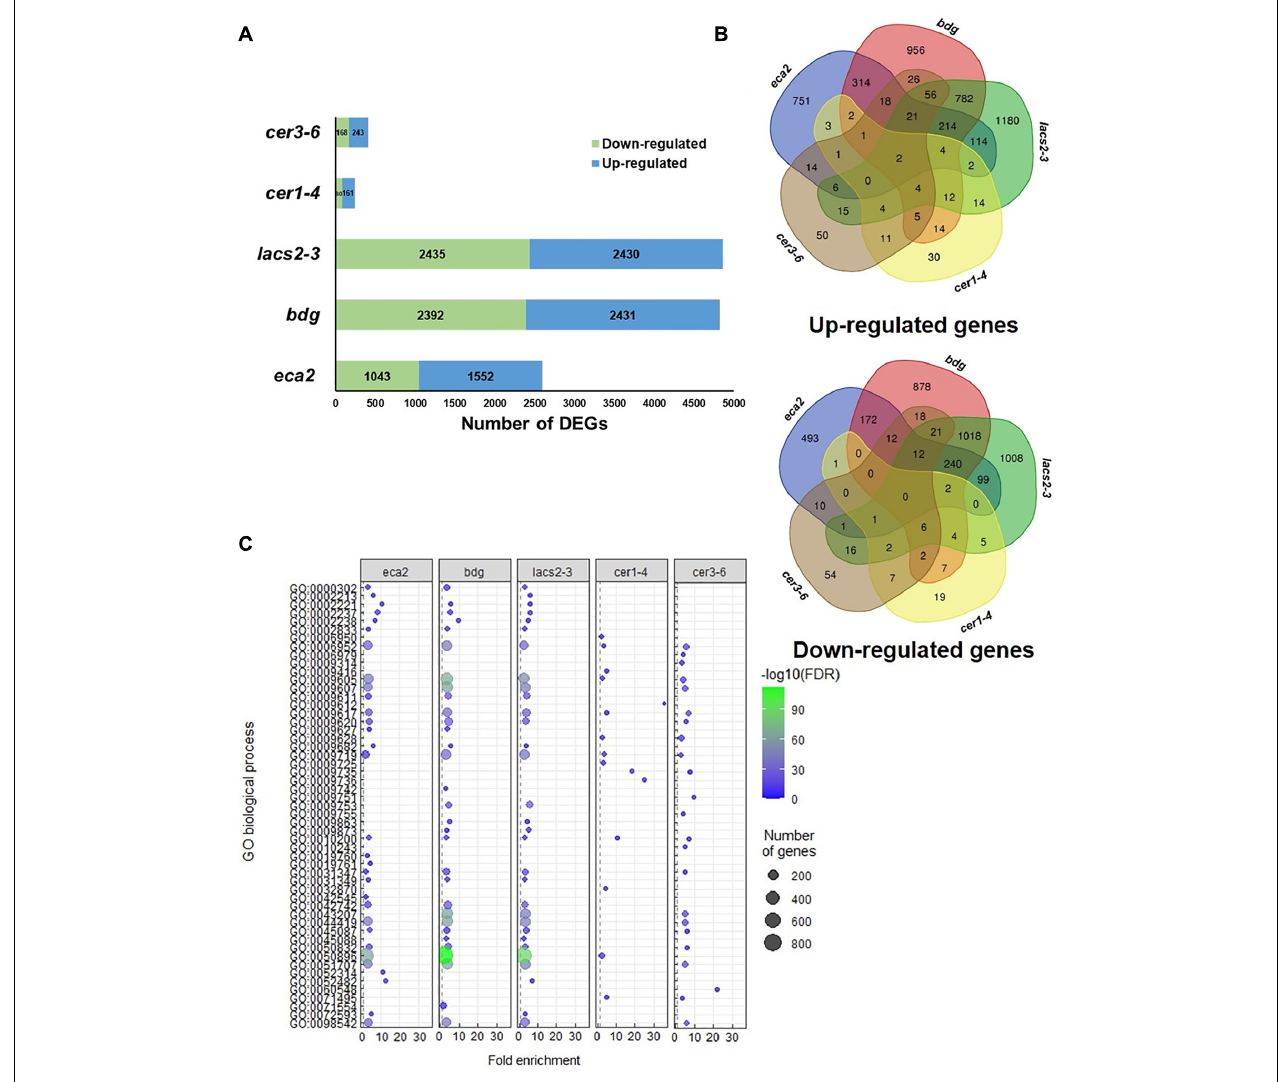
FIGURE 6 | Transcriptome analysis of cuticular mutants infected with Botrytis cinerea (6 hpi). (A) Number of DEGs (Log2FC ≥ 1 or ≤ –1 with an adjusted p -value ≤ 0.05) identified in the cutin and wax mutants. (B) Venn diagrams show the overlap of upregulated and downregulated genes among the cutin or wax mutants. (C) GO analysis for upregulated genes in each cuticular mutant. Dot plot shows fold enrichment (FDR < 0.01) of the top 25 most significant enrichment terms of biological